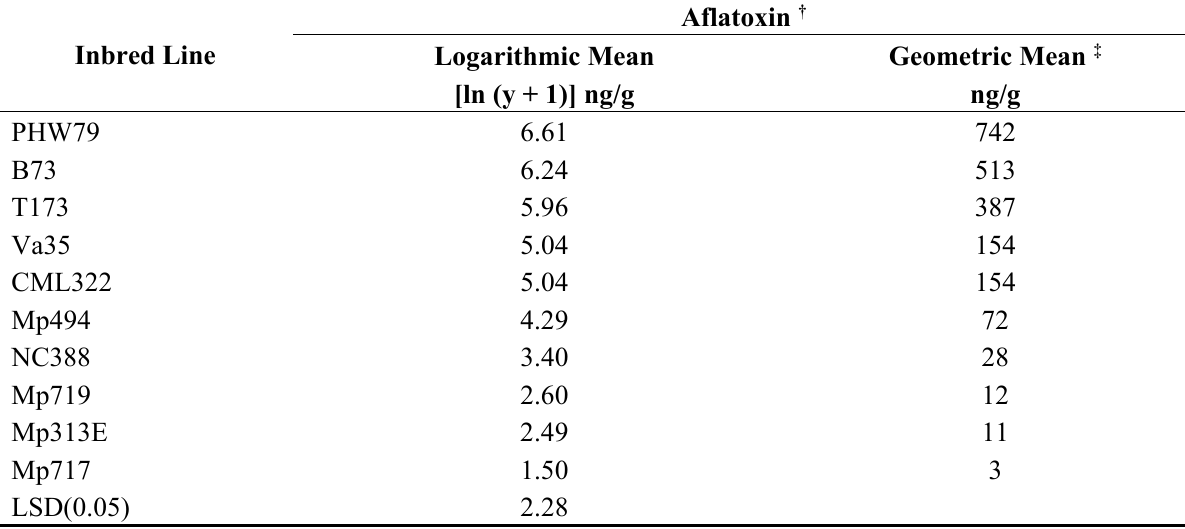
Table 1. Mean aflatoxin accumulation in 10 parental inbred lines grown at Mississippi State in 2013 and 2014.